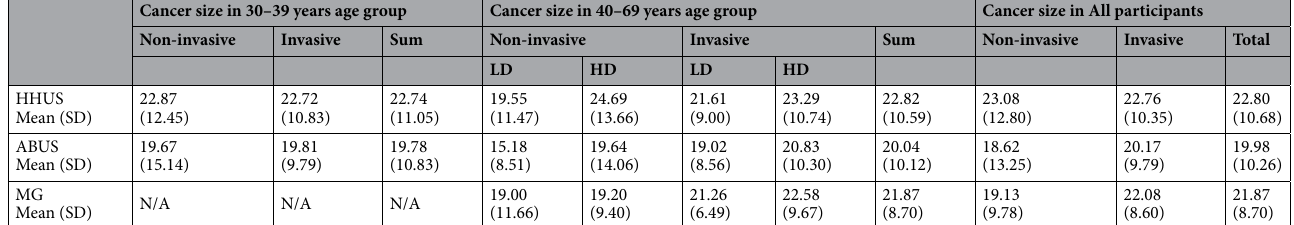
Table 3. Cancer size distribution. LD: lower-Low-density breast subgroup; HD: High-density breast subgroup; SUM: